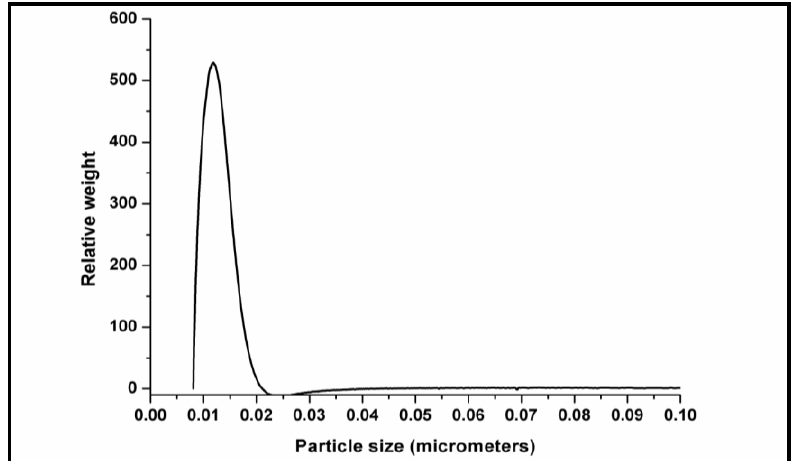
Figure 7. Particle size distributions of TiO 2 nanoparticles as determined by the centrifugal particle sedimentation (CPS) method.